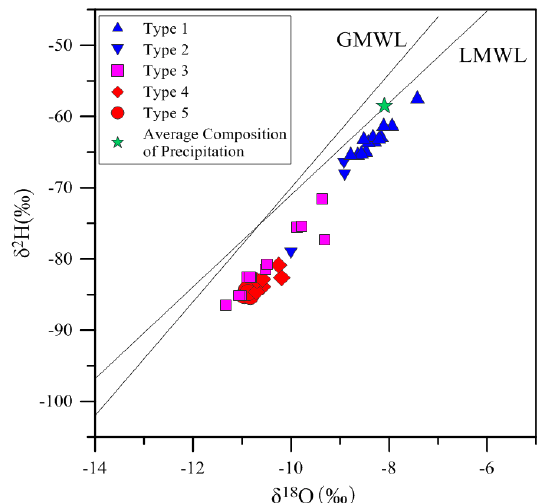
Figure 6. The plot of the δ 2 H vs. δ 18 O values of groundwater investigated in this study as compared to the local meteoric water line (LMWL) and global meteoric water line (GMWL): The green pentagram represents the mean isotopic composition of modern rainfall in the Ordos Plateau (The data is from Reference [23]). Water 2019 , 11 , x FOR PEER REVIEW